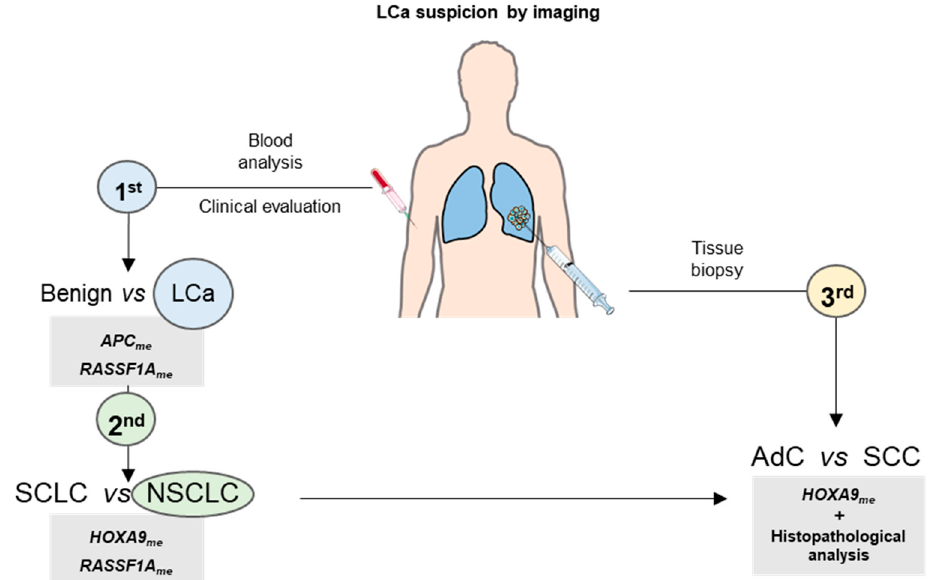
Figure 4. Proposed algorithm for lung cancer (LCa) subtyping when LCa is suspected by imaging.